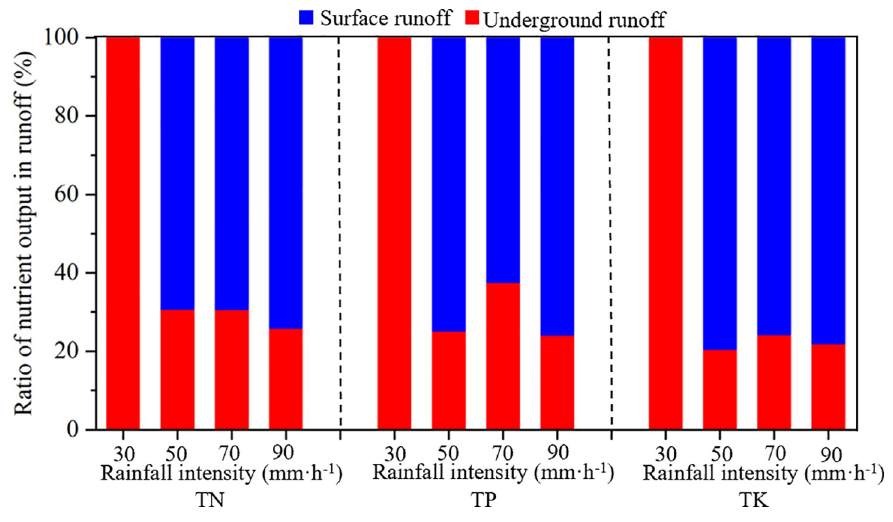
Fig 8. Proportion of nutrient loss in surface and underground